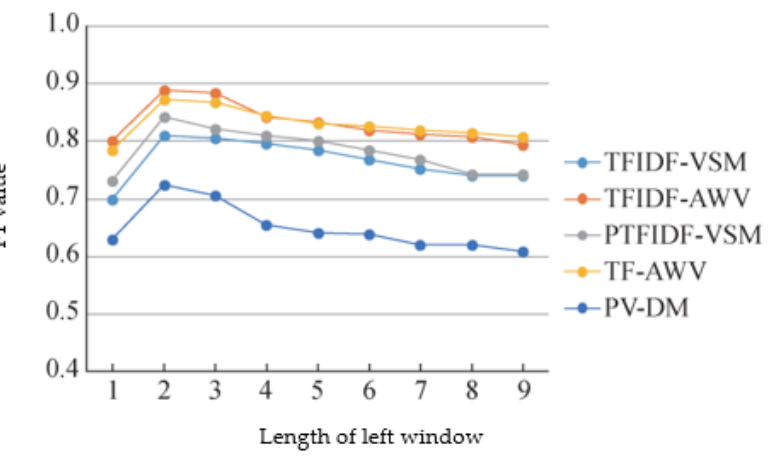
Figure 2. Variation in implicit reference sentence detection performance with the length of the left window (right window length is fixed at 10).